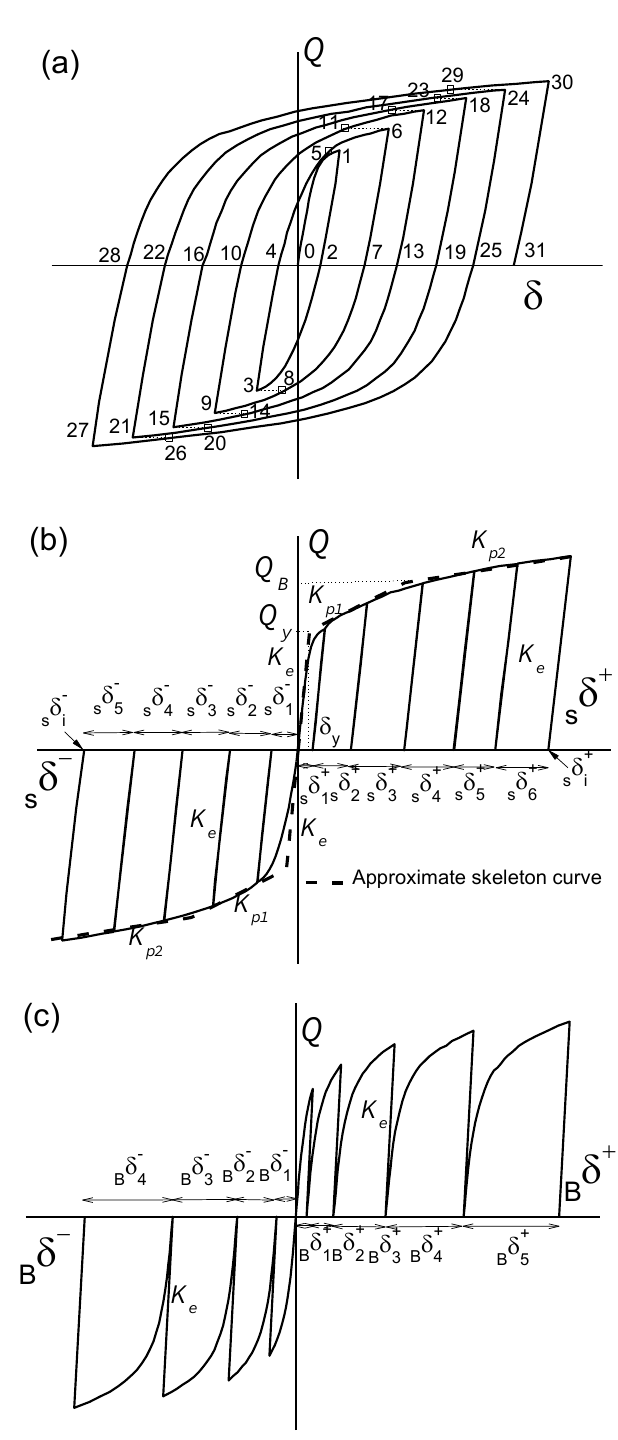
Figure 11. Decomposition of the force displacement, Q-δ, curve: ( a ) Entire Q-δ curve; ( b ) skeleton part; ( c ) Bauschinger part.